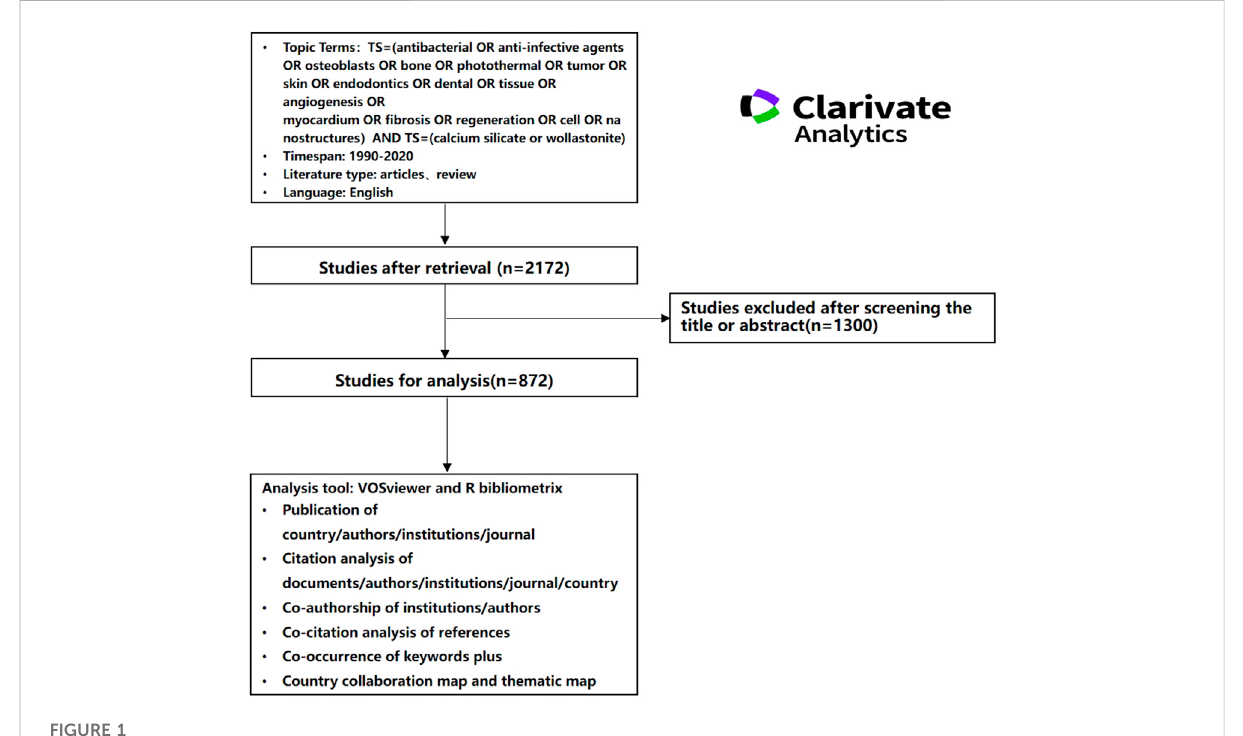
FIGURE 1 Flow diagram of identi fi cation of relevant